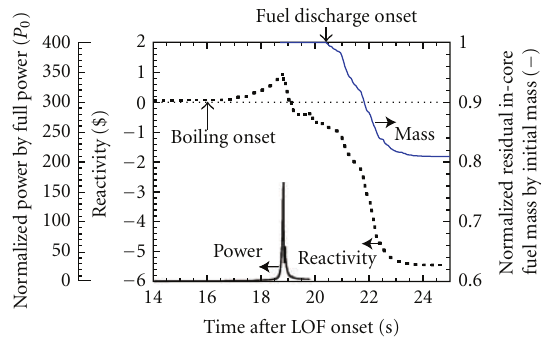
Figure 9: Initiating and early fuel discharge phases of unprotected loss-of-flow accident.